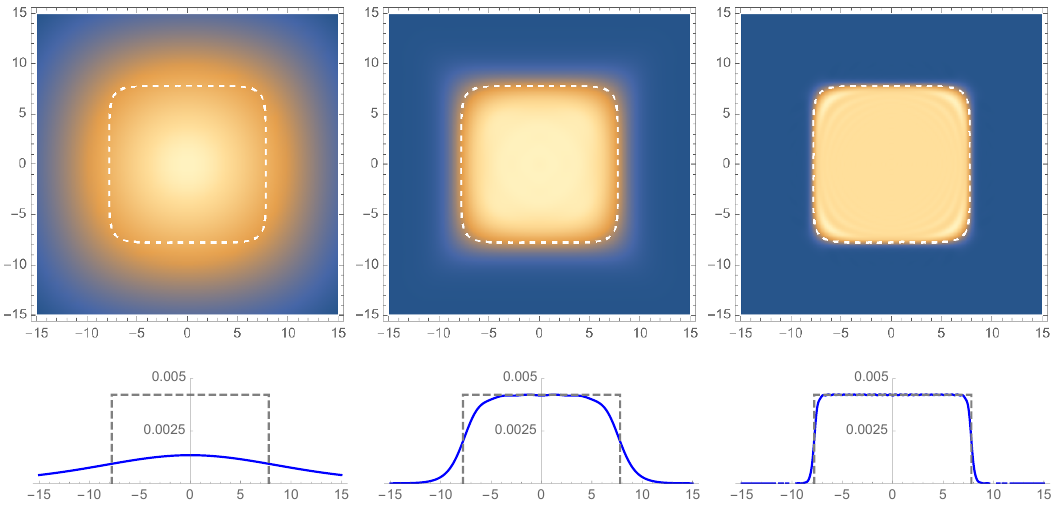
Figure 4 . Same plots for N= ~ = 3 =(cid:25) . On the left N = 1, in the middle N = 6, on the right N =